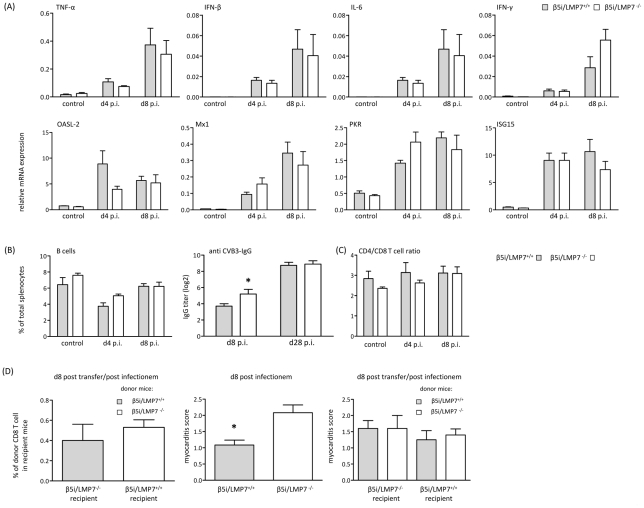
Adaptive immune responses in CVB3-infected IP-deficient mice.(A) Quantitative real-time PCR: mRNA expression of indicated cytokines (first row) and antiviral molecules of the innate immune response (second row) was determined in the hearts of β5i/LMP7+/+ and β5i/LMP7-/- mice at d4 and d8 p.i. Data shown are mean of n≥5 mice±SEM. (B)+(C) Flow cytometric analysis was completed on splenocytes isolated from β5i/LMP7+/+ and β5i/LMP7-/- mice at d4 and d8 p.i. (n = 6 mice, representative for 3 independent experiments). (B) Cell numbers of B cells (CD19+, B220+) are illustrated as % of each cell population in comparison to the total number of cells from each spleen (left panel). CVB3-specific IgG levels were determined in sera collected at indicated time points, and titers of virus-specific IgG antibodies were determined by a CVB3-specific ELISA (n≥8 mice, right panel). (C) Ratios of CD4+ T cells (CD4+, CD3+) and CD8+ T cells (CD8+, CD3+) are illustrated. (D) For T cell transfer studies splenic CD8 T cells were separated by MACS (Miltenyi Biotec) from 1×107 splenocytes (Fig. S2B). Left panel: To assess T cell survival after adoptive transfer, CD8 T cells were transferred from CVB3-infected β5i/LMP7+/+ (CD45.1) into β5i/LMP7-/- (CD45.2) mice and from β5i/LMP7-/- mice (CD45.2) into β5i/LMP7+/+ mice (CD45.1). Recipient mice were infected with CVB3 and sacrificed at d8 p.i. T cell survival was determined in splenocytes by flow cytometry. Middle panel: Prior to adoptive T cell transfer, β5i/LMP7+/+ and β5i/LMP7-/- mice were infected with CVB3 and myocarditis scores were determined at d8 p.i. (n = 5 mice). Right panel: Then, splenic CD8 T cells were isolated from these CVB3-infected mice at d8 p.i. as described above; 1–2×106 CD8+ T cells from one donor were injected i.v. through the tail vein into one recipient. Recipient mice were then infected with CVB3 i.p. and sacrificed at d8 p.i. Myocardial damage was evaluated in HE staining as described above. Data shown are mean for n = 5 mice and are representative for two independent experiments.